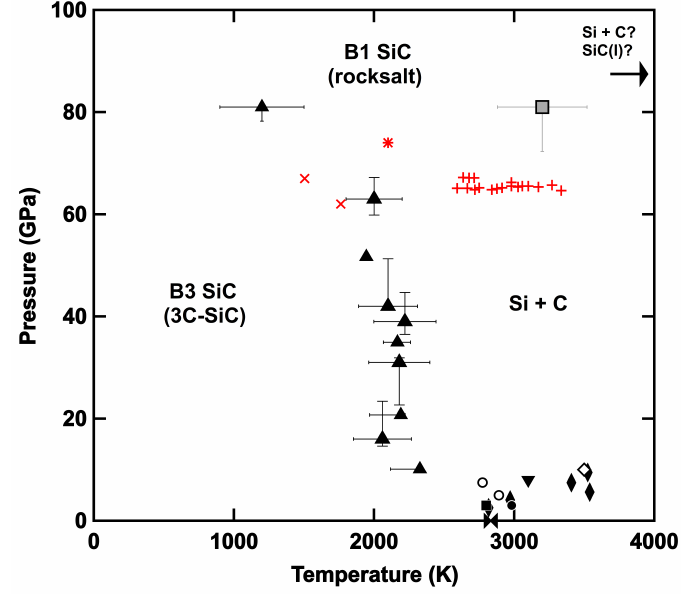
Figure 5. High-pressure and -temperature phase diagram of SiC melting and decomposition. Solid black symbols indicate studies finding incongruent melting (decomposition) (bowtie [19], circle [106], diamonds [109], upside down triangle [110], square [17], triangles (multi-wavelength imaging radiometry and X-ray diffraction) [18]) while open symbols indicate studies observing congruent melting to SiC liquid (open circles [108], diamond [107]). The solid grey square indicates P-T conditions where no melting of any kind was observed [18]. Red symbols indicate the experimentally observed conditions of the B3 to B1 transition in the LHDAC (red x’s [24], red asterisk [27], red plus signs